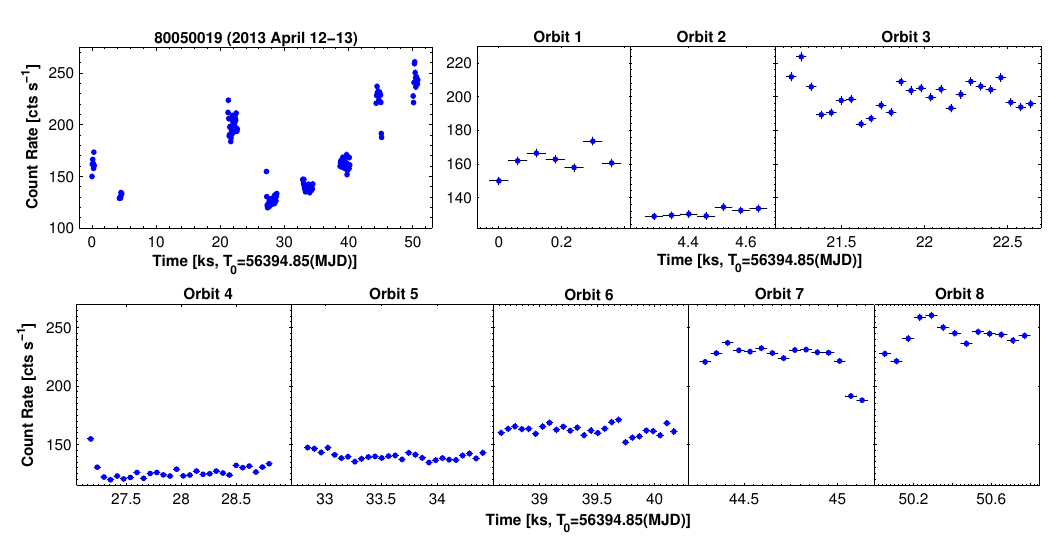
Figure 1. The first panel in the upper row: the most extreme intraday variability of Mrk421 during the Swift-X-ray Telescope (XRT) observations performed on 12–13 April 2013; the next panels and bottom row: zoomed-in 0.3–10 keV light curves from each orbit of this